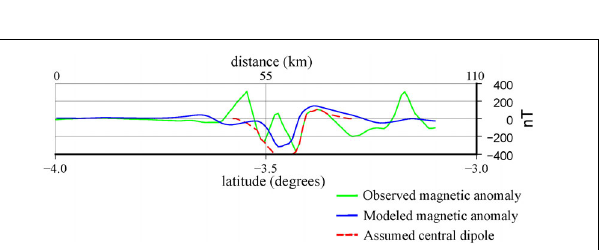
FIGURE 11 | Magnetic anomaly of the profile 8. Green: observed data ( Figure 4 ). Blue: modeled data ( Figure 9 ). Dotted red: assumed central